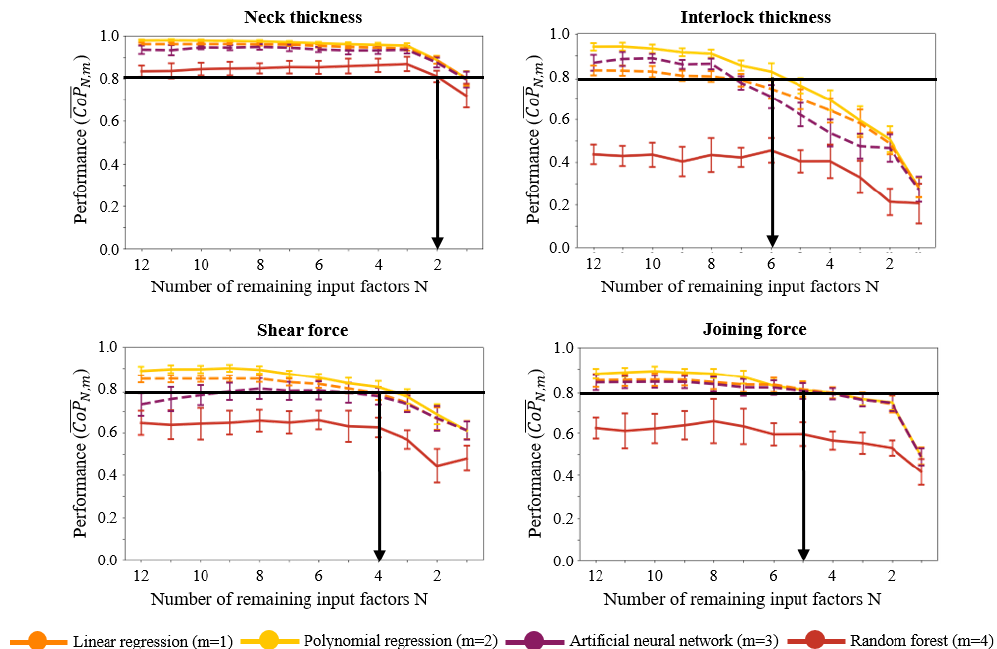
Figure 7. Performance of the machine learning algorithms on limited input data.